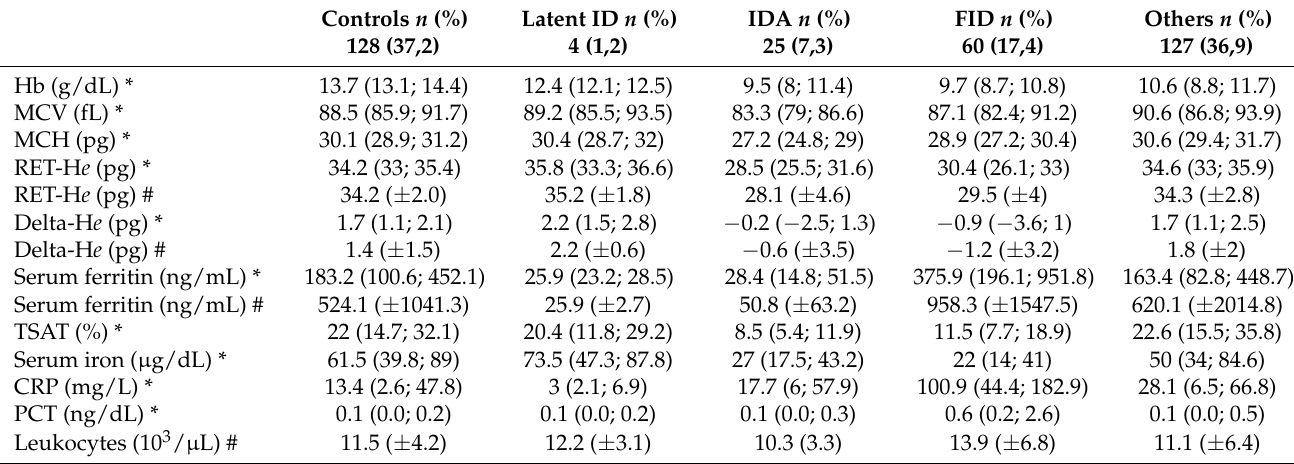
Table 3. Laboratory data of the study population.